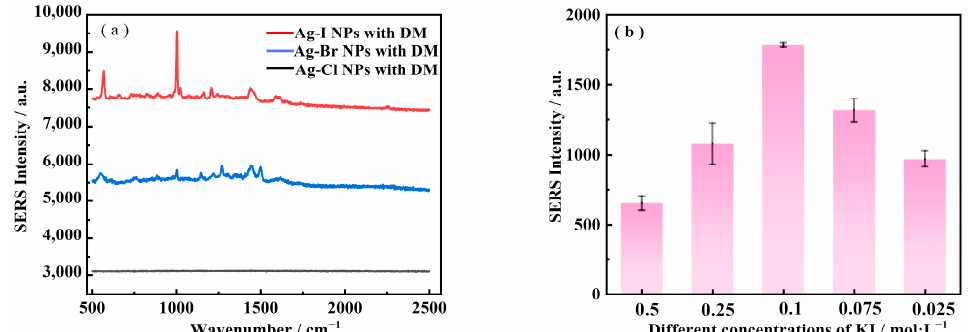
Figure 3. ( a ) SERS spectra of 1 ppm DM obtained with three halides (0.1 M I − , Br − , and Cl − ) modified Ag NPs by the volume ratio of 10 μ L (DM): 20 μ L (Ag NPs): 5 μ L (halide ions) in our practical research. ( b ) SERS performance of 1 ppm DM was obtained with Ag NPs modified by different concentrations of KI. The concentration of KI was 0.5 M, 0.25 M, 0.1 M, 0.075 M, and 0.025 M, respectively. Laser